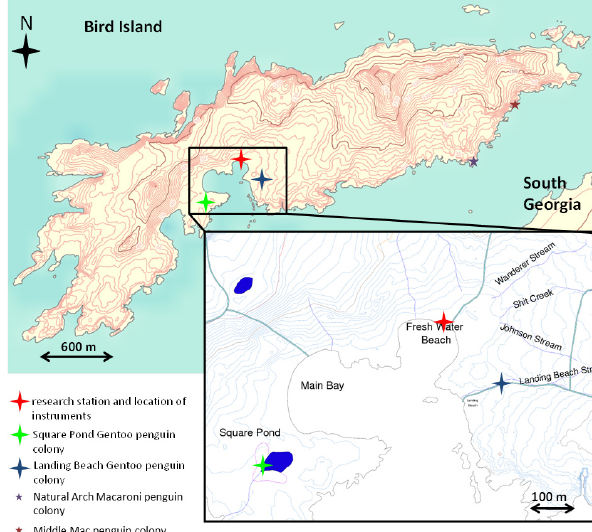
Fig. 1. Map of Bird Island and zoom on the surroundings of the research station (large red star), also showing the location of two nearby gentoo penguin colonies (large green star and blue star). Small stars indicate other penguin colonies on Bird Island which in- fluenced the organic aerosol composition measured at the research station. The thick dark-red contours on the main map and insert map indicate 100m altitude steps (GIS map source: British Antarc- tic